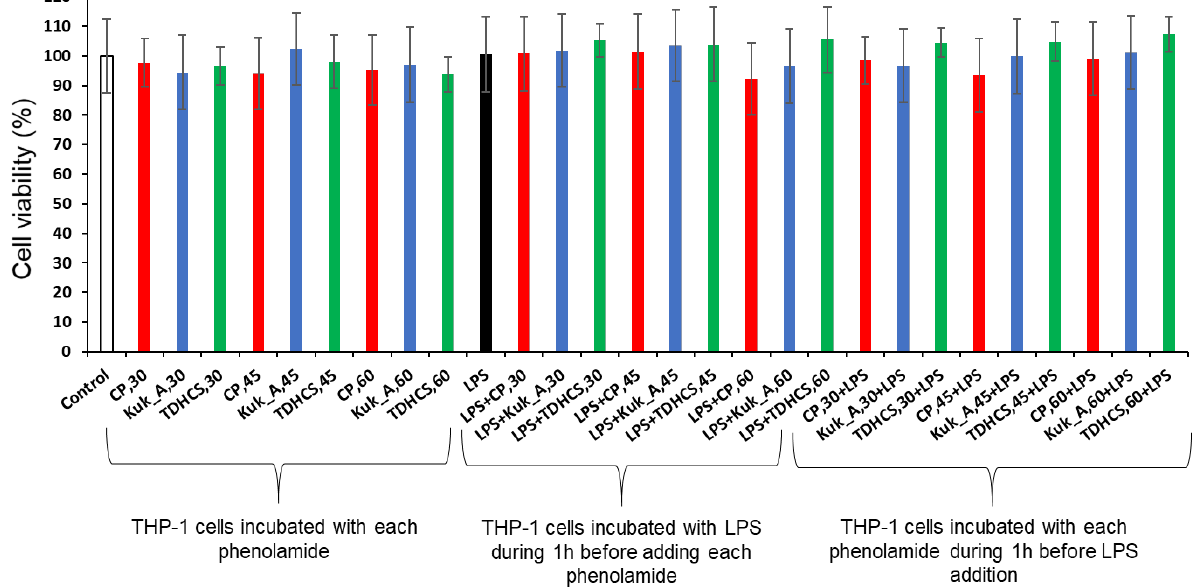
Figure 3. Effects of the three phenolamides on the viability of differentiated THP-1 cells. Four concentrations (30, 45 and 60 µM) of CP, Kuk_A and TDHCS were tested. Differentiated THP-1 cells were incubated either with these molecules alone or with 100 ng/mL of LPS added one hour before or after the phenolamide addition. Twenty-four hours later, THP-1 cell viability was analyzed by crystal violet assay and optical density (O.D.) was measured at 595 nm. This figure is representative of six independent experiments performed in triplicates. “Control” corresponds to a THP-1 cell culture in which no product was added (negative control). “LPS” corresponds to a THP-1 cell culture in which only LPS was added (positive control). “LPS + phenolamide, 30” indicates that LPS was added before phenolamide at a concentration of 30 µM while “phenolamide, 30 + LPS’ indicated the phenolamide at a concentration of 30 µM was added before LPS. Data are presented as the mean ± S.D. t-tests were used to identify statistically significant differences.